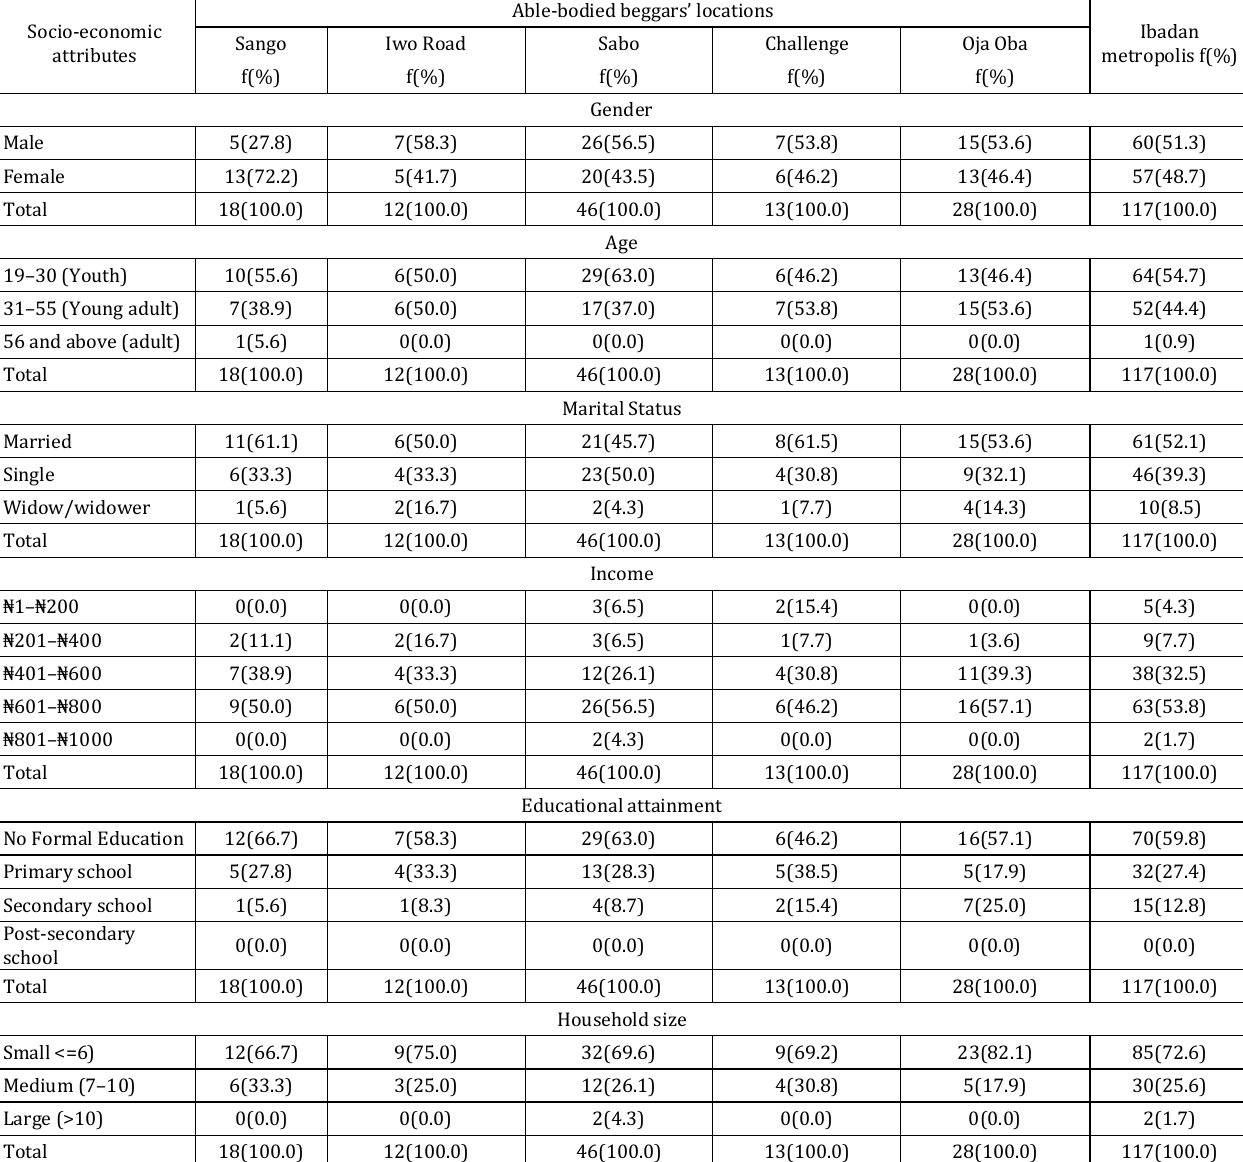
Table 1. Socio-economic attributes of able-bodied